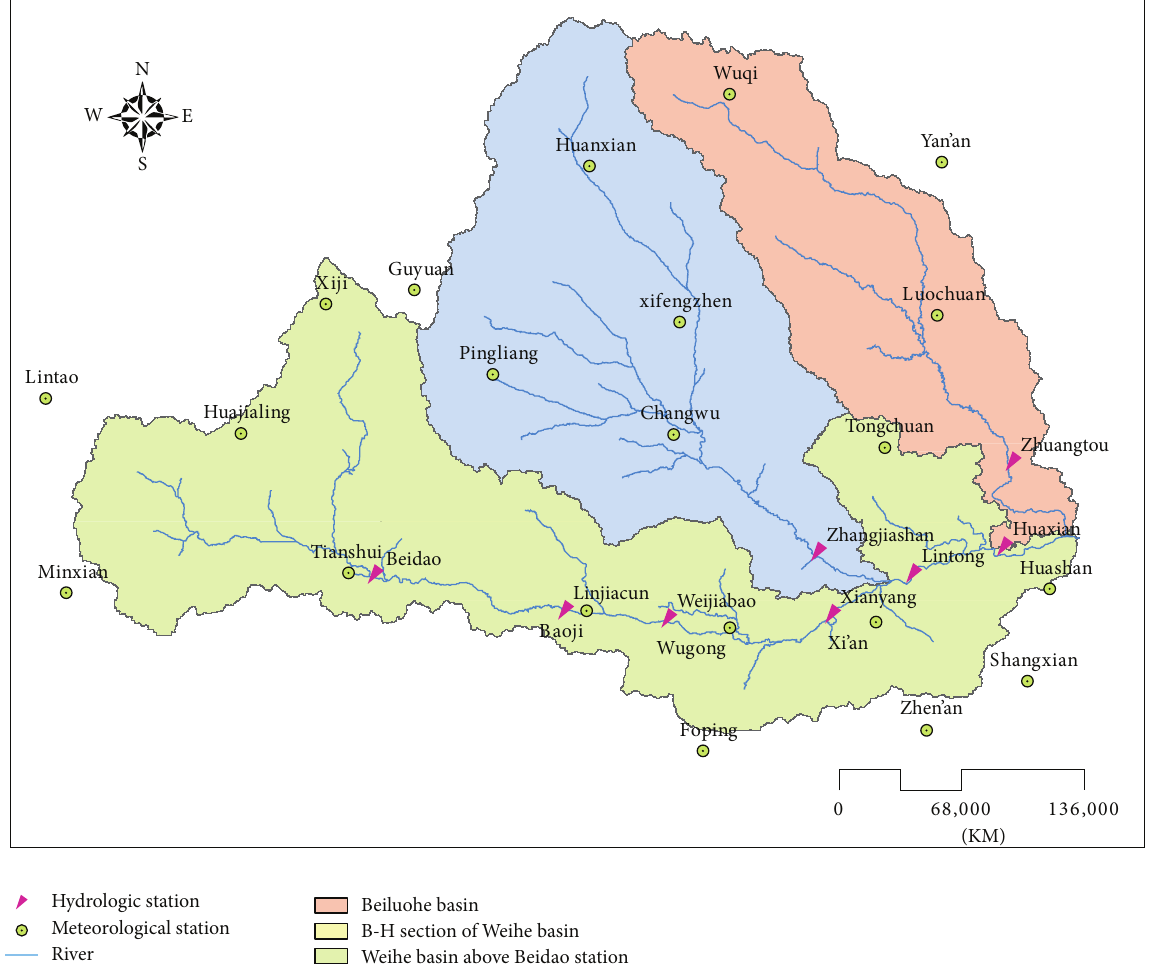
Figure 1: Map of the Weihe basin showing the four subbasins and locations of hydrological and meteorological